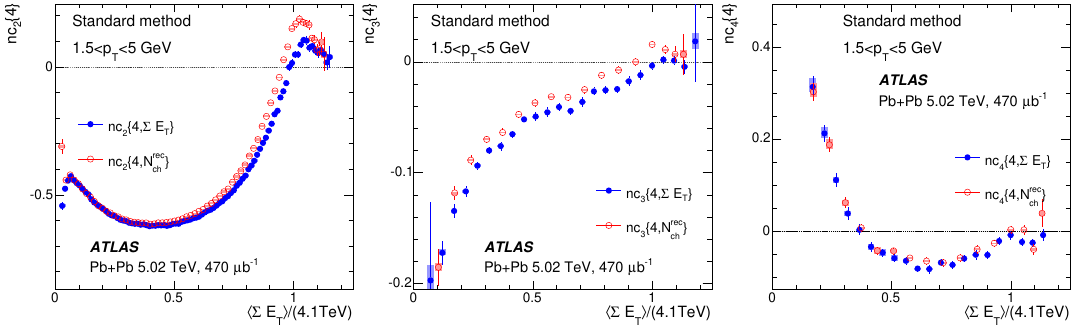
Figure 16 . The comparison of normalized four-particle cumulants nc n f 4 ; (cid:6) E T g and nc n f 4 ; N rec as a function of h (cid:6) E T i for n = 2 (left panel), n = 3 (middle panel), and n = 4 (right panel) for charged particles 1 : 5 < p T < 5 GeV. The error bars and shaded boxes represent the statistical and systematic uncertainties, respectively. Zero is indicated by a dotted